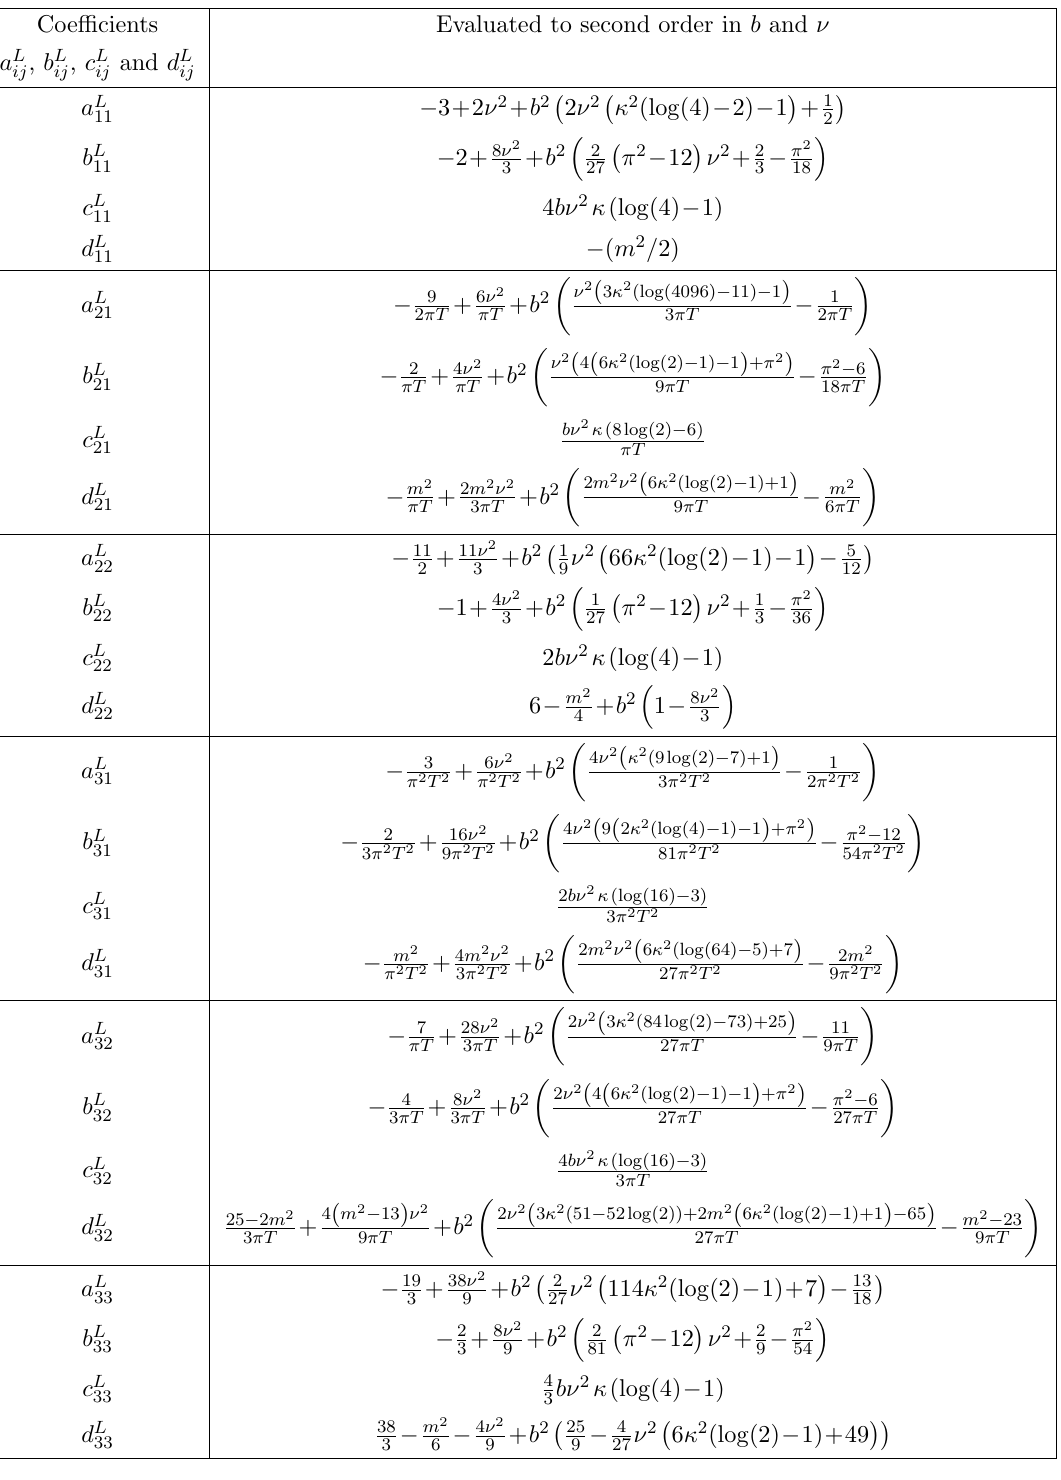
Table 2 . Longitudinal dynamics of scalar